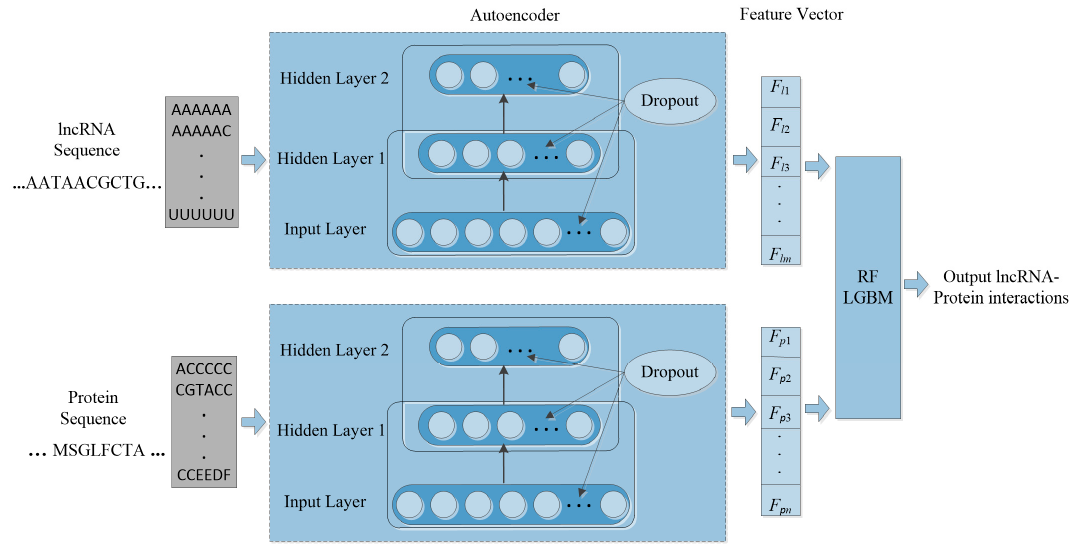
Figure 1. The workflow of PLRPIM model.